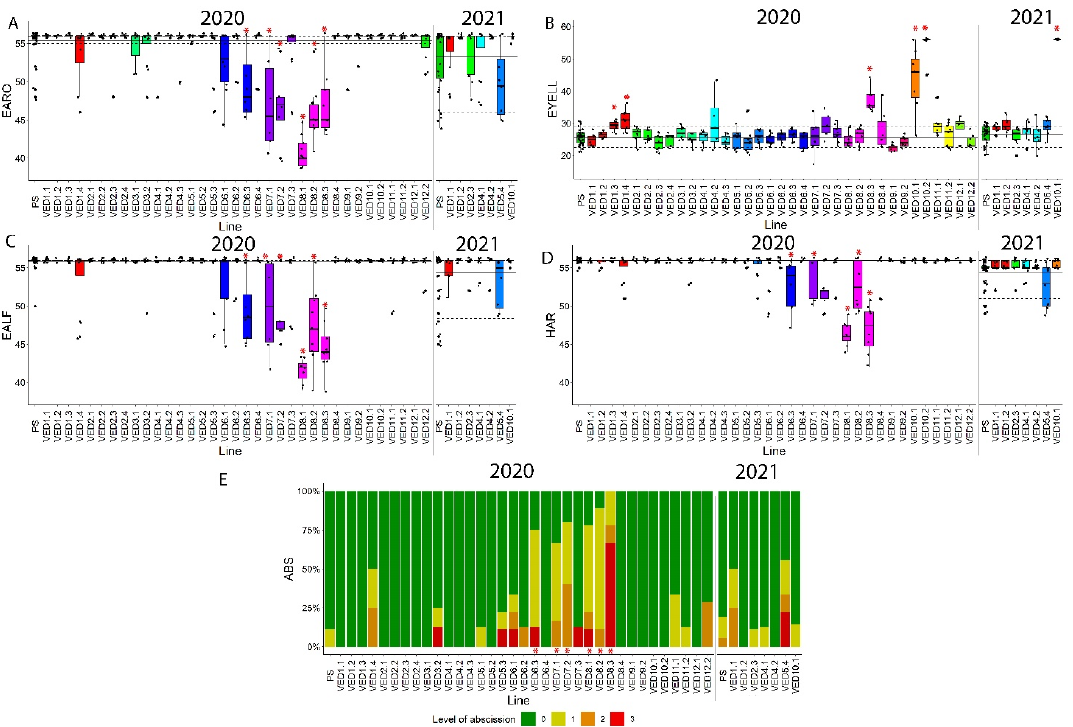
Figure 6. Ripening-related phenotypes of the population in 2020 and 2021. Replicates are represented with dark circles. Red asterisk indicates p -value < 0.05 and different colors indicate different chromosomes. ( A ) Earliness of aroma (EARO) in days after pollination (DAP). ( B ) Earliness of yellowing of the rind (EYELL) in DAP. ( C ) Abscission layer formation (EALF) in DAP. ( D ) Harvest date (HAR) in DAP. ( E ) Level of abscission (ABS) expressed as frequency (%). chromosome 8. VED8.1, VED8.2 and VED8.3 had climacteric behavior, similar in VED8.1